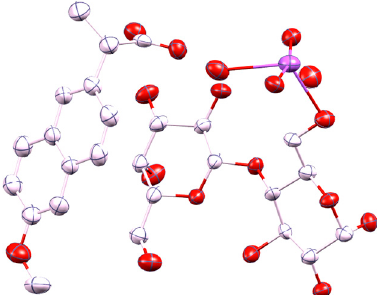
Figure 1. Displacement ellipsoid plot of the NaN-Lact-4H 2 O co-crystal showing the asymmetric unit (ellipsoids drawn at the 50% probability level); color code: Na-purple, O-red, C-light pink; H atoms are omitted.